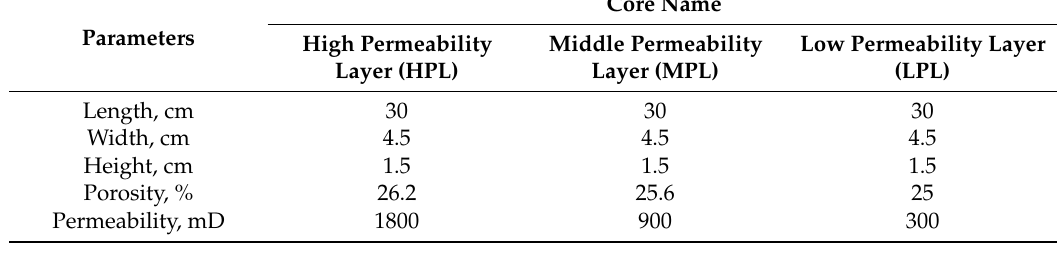
Table 4. Parameters of core samples used to study the relationship between TPG and mobility.